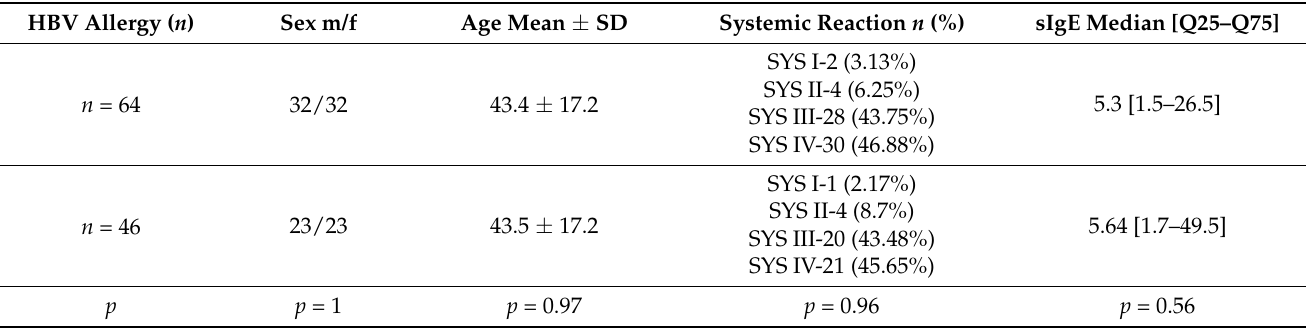
Table 2. Demographic and clinical characteristics (64 patients vs. 46